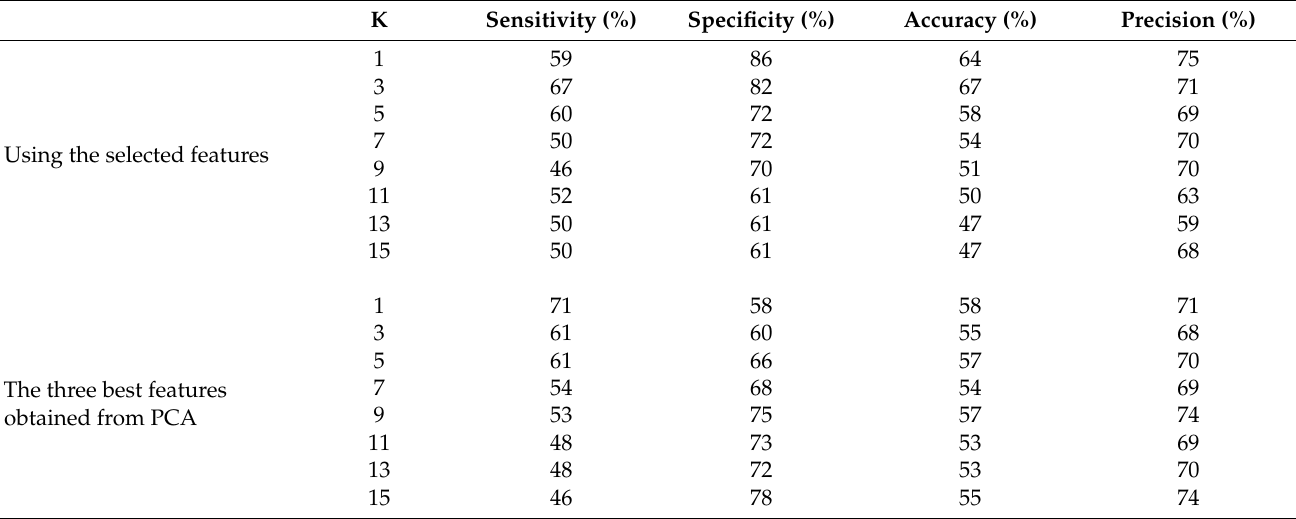
Table 2. The sensitivity, specificity, accuracy, and precision from a cross-validation analysis using the KNN models with k = 1 to k = 15 in classifying high- and low-calibre skaters. The feature spaces of the KNN models are either selected kinematic features of lower limb joint motions, obtained from Table 1, or the best three components obtained from the PCA on on-ice distinctive features. K Sensitivity (%) Accuracy (%) Precision